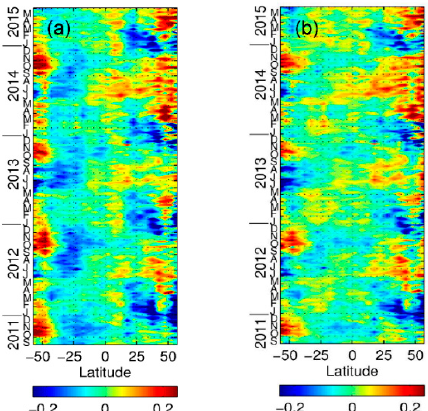
Figure 4. ( a ) Latitude-time distribution of the zonally averaged differences (psu) between the weekly Level-3 SSS maps and the corresponding Argo data. The error statistics were computed by comparing Argo float measurements for a given week with SSS values at the same locations obtained by interpolation of the corresponding Level-3 SSS maps. The zonally averaged biases were computed by averaging these statistics over 5°-latitude bins. ( b ) The same as in ( a ), but with the 3-year mean (September 2011 to August 2014) subtracted.